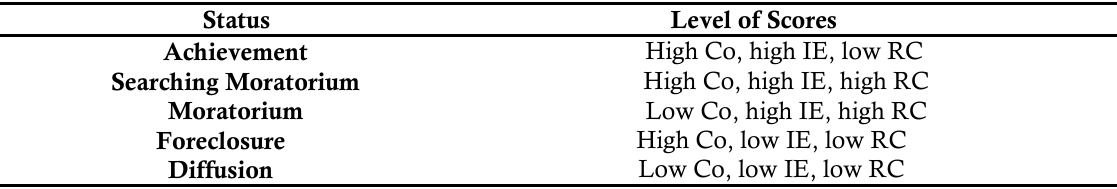
Table 2. Religious Identity Status